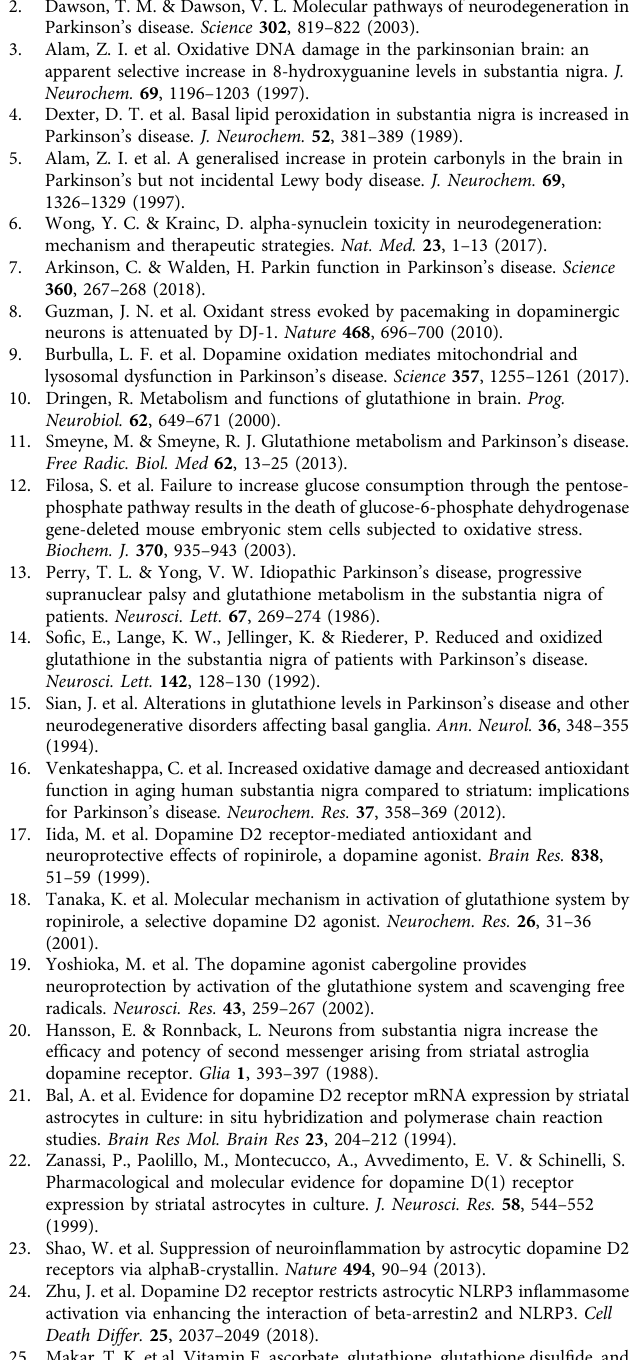
Figs. 1 – 8, including a brief description for each fi gure, sample size, statistical tests performed, P values, post hoc test, and post hoc test P values were provided as a Source Data fi le. Other data that support the fi ndings of this study are available from the corresponding author upon reasonable